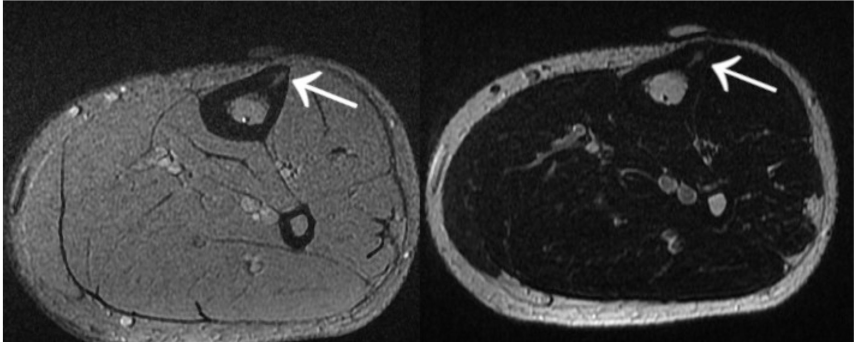
Figure 20. MRI scans showing a focus of OO (arrows) in the left tibia.